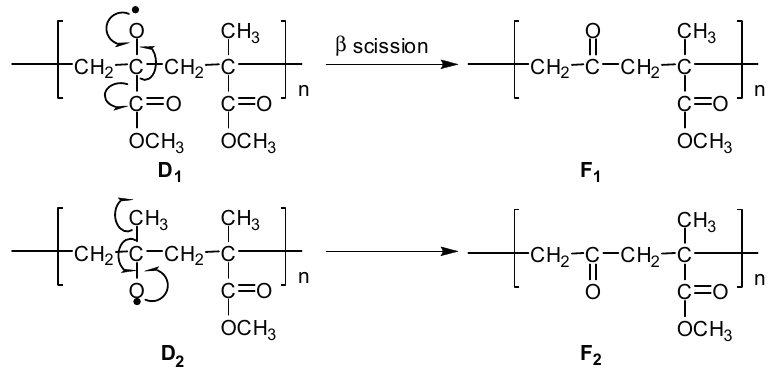
Figure 7. Formation of ketonic polymers F 1 and F 2 .